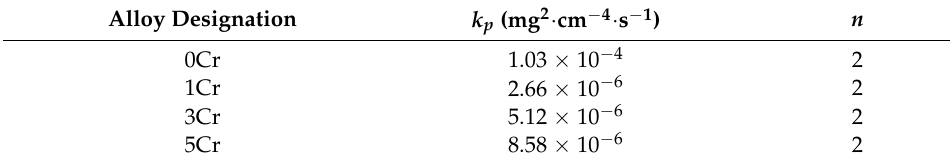
Table 2. Parabolic rate constant ( k p ) for all the alloys at 900 °C.